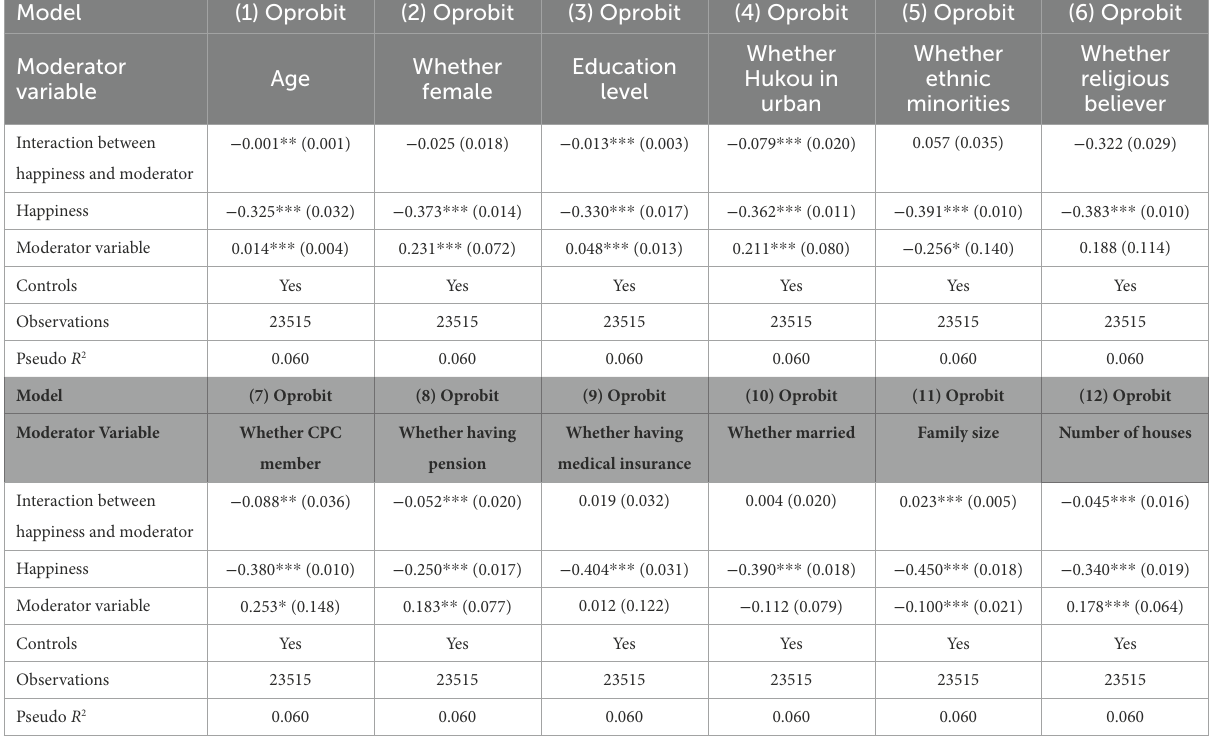
TABLE 2 Demographic heterogeneities.